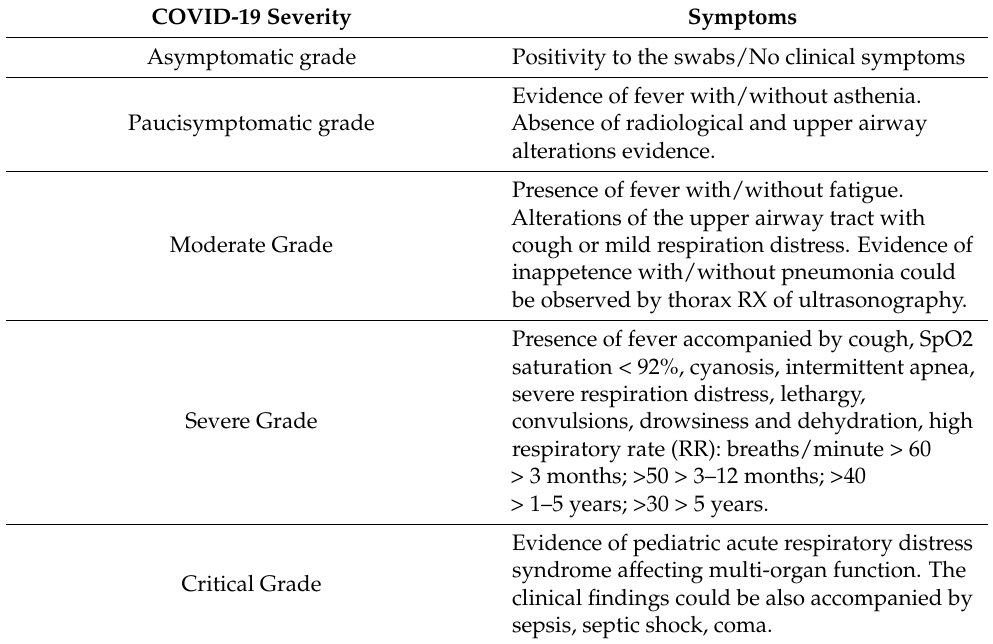
Table 1. Summary of grading and clinical features of COVID-19